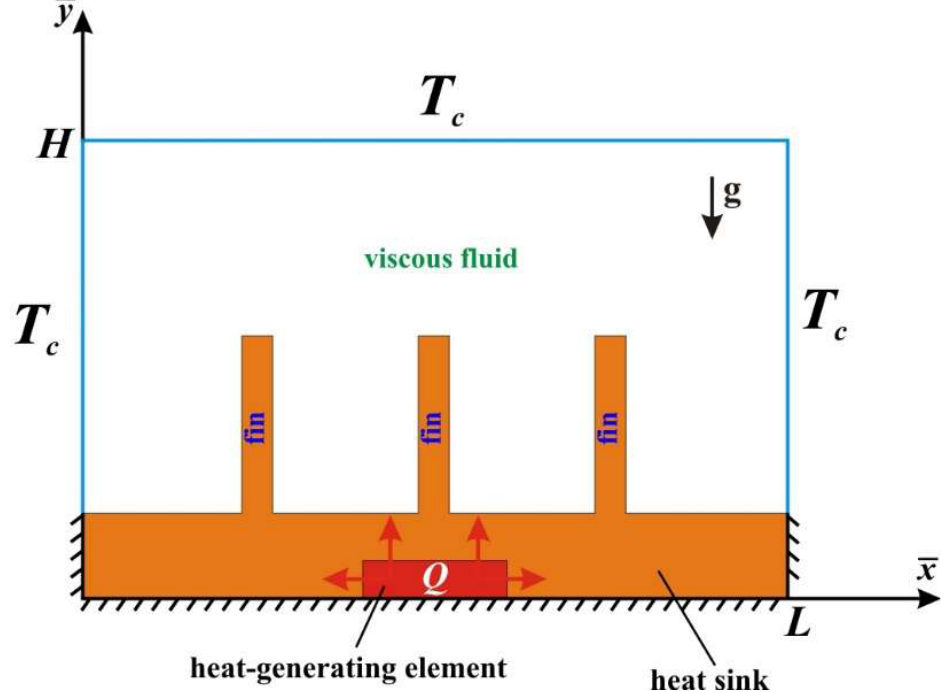
approach is employed. The transport processes in porous fins are modeled on the basis of the Brinkman–extended Darcy approximation.